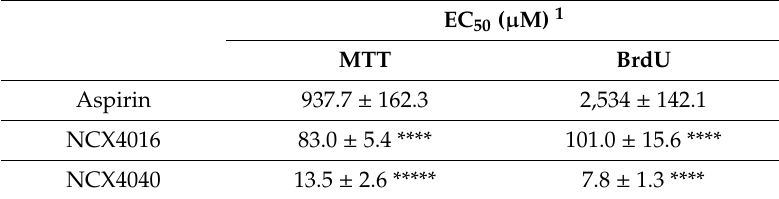
Figure 1. Chemical structure of the NO-aspirins used in this study. The structure of aspirin is highlighted in red, and the nitro (nitric oxide-releasing) group is shown in blue. The linker group is shown in black. Table 1. Effect of NO-aspirins on the viability and proliferation of non-small-cell lung cancer (NSCLC) cells.